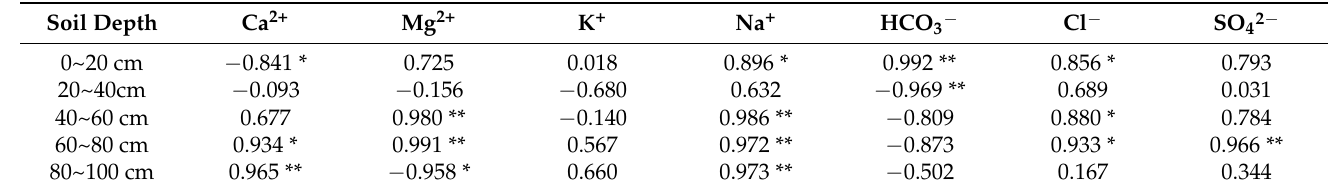
Table 1. Correlation coefficient ( r ) between total salt contents and concentrations of indicated ions in soil from indicated depths in areas occupied by the six Kalidium species.